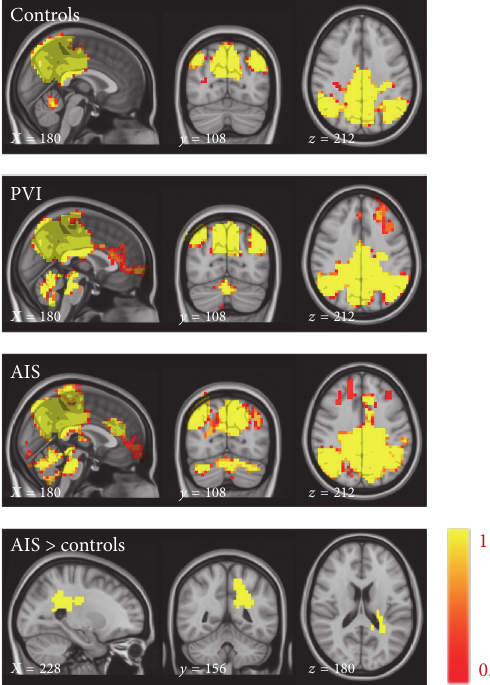
Figure 5: Connectivity maps of the posterior precuneus part of the default mode network for the controls, periventricular venous infarction (PVI), arterial ischemic stroke (AIS), and a map of the areas with increased connectivity in AIS versus control (FDR 0.1). Color map from 0.949 (red) to 1